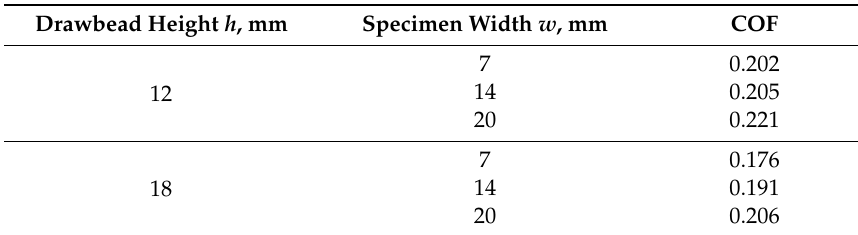
Table 3. Experimentally determined values of coe ffi cient of friction.